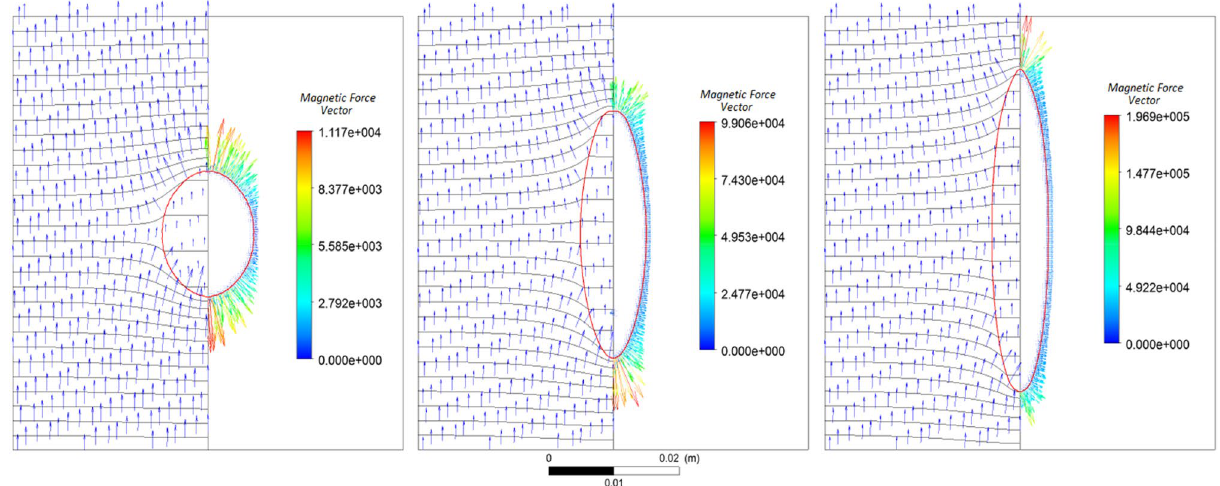
Figure 3. The final shape of the droplet in the steady-state from left to right for three magnetic field strengths of 837, 2043, and 2641 A/m, respectively. In each figure, on the right-hand side, the force vectors with a color map showing the magnetic force magnitude in N/m 3 , and on the left-hand side, the magnetic field vectors with constant magnetic potential lines are shown.